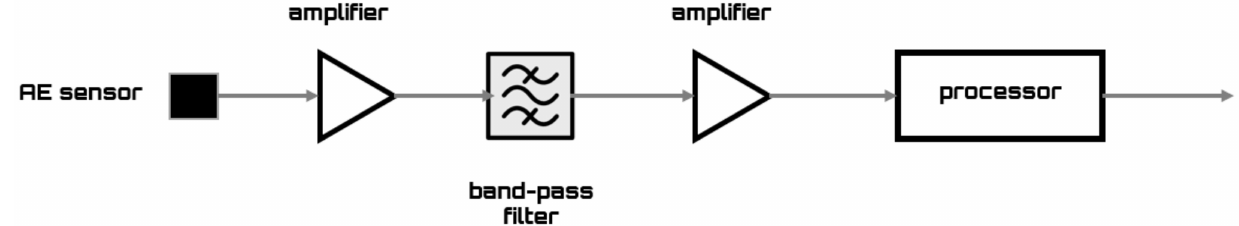
Figure 1. Acoustic emission detection scheme. AE sensor captures the signal and passes it to a preamp, which then sends it to a band-pass filter. Subsequently, the selected spectrum is amplified and passed to the signal